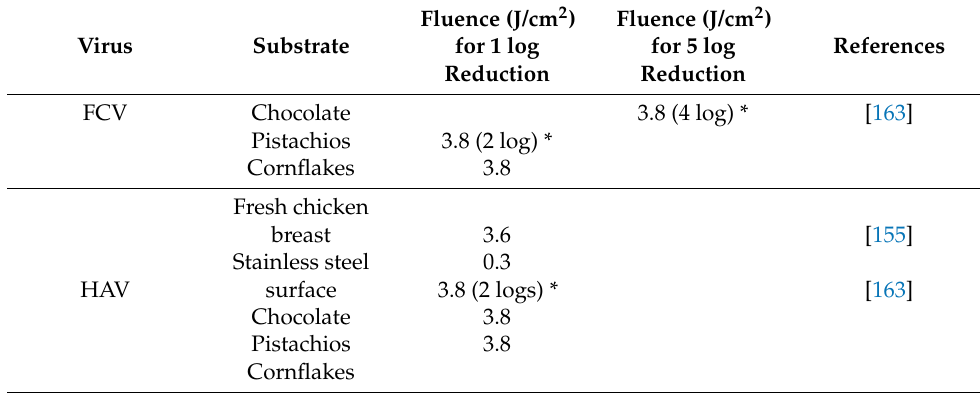
Table 3. Inactivation of viruses by UV-C on foods other than